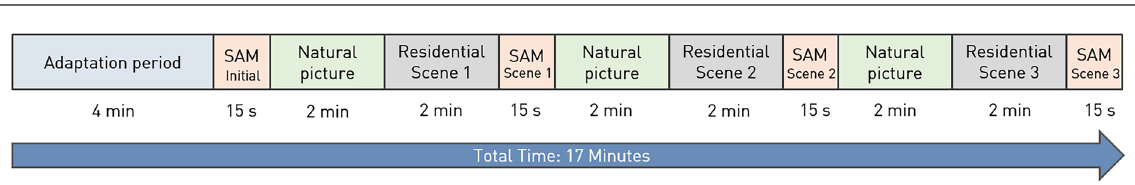
Figure 4. Overview of the experimental procedure using Virtual Reality stimuli in a mobile acoustic-visual lab. SAM Self-Assessment Manikin to measure valence and cognitive arousal. Skin conductance levels were measured along the entire experimental procedure. Total time changes depending on the time each participant used to grade the SAMs (15 s only as a